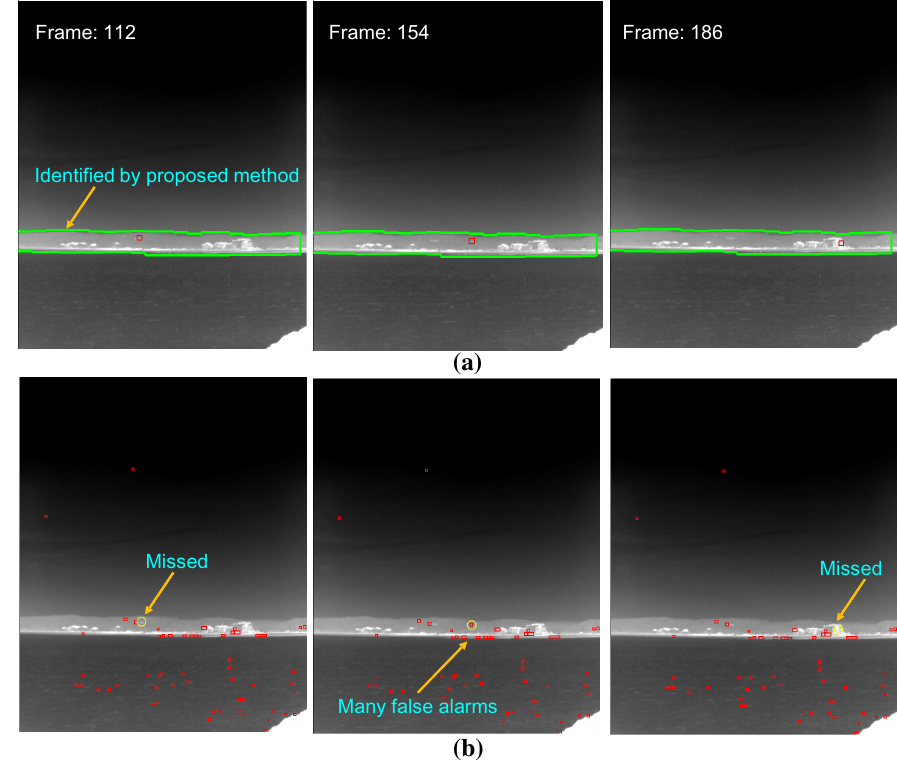
Figure 26. Effect of the coast region information in the infrared small target detection problem for the synthetic DB: ( a ) application of the temporal filter-based detector (TCF) for the identified coast region; ( b ) application of a spatial filter-based detector (top-hat). The yellow circles denote the ground truths, and the red rectangles represent the detection results.